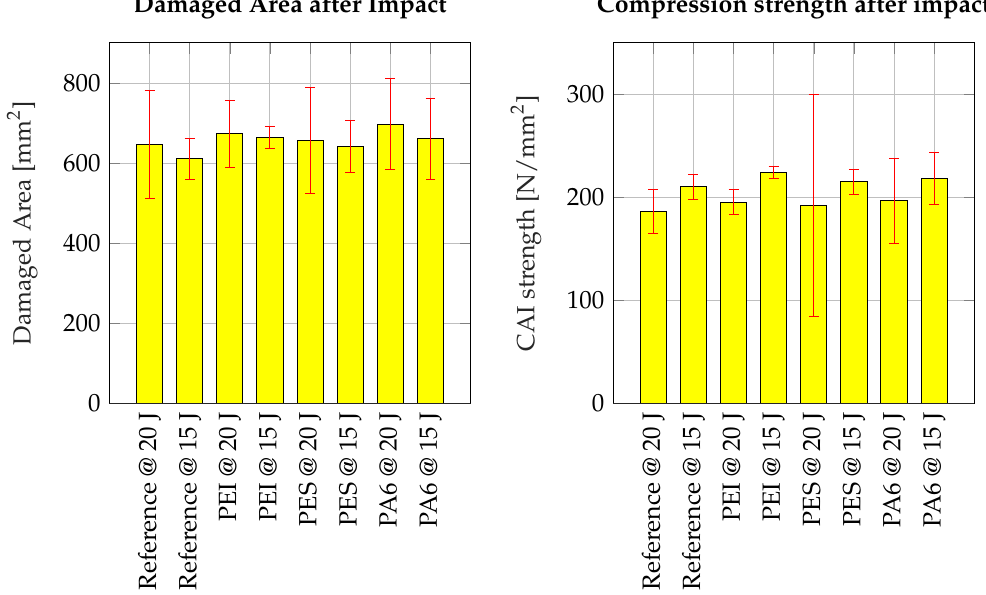
Figure 13. Influence of thermoplastic films on the damaged area and compression strength after impact. The left diagram shows the damaged area after impact, the right diagram indicates the compression strengths after